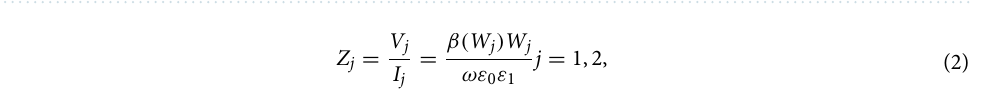
Figure 3. Schematic of relations between circuit input and outputs through ( a ) Scattering matrix. ( b ) Transfer